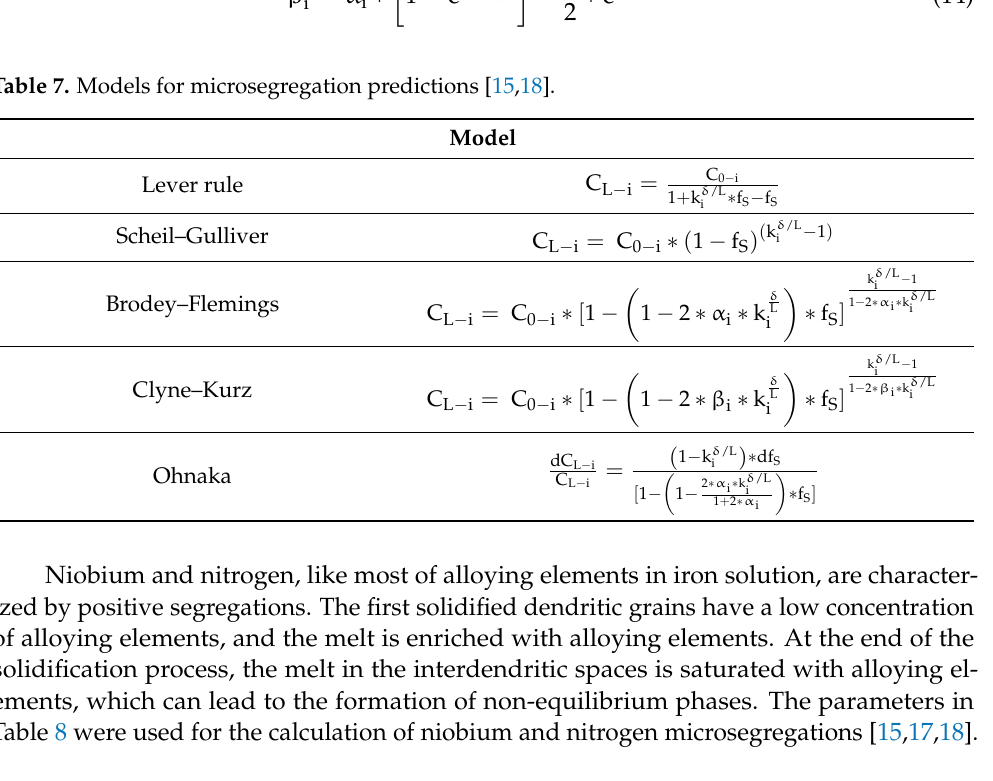
Table 8. Parameters for calculation of niobium and nitrogen microsegregations. Data from [15,18].